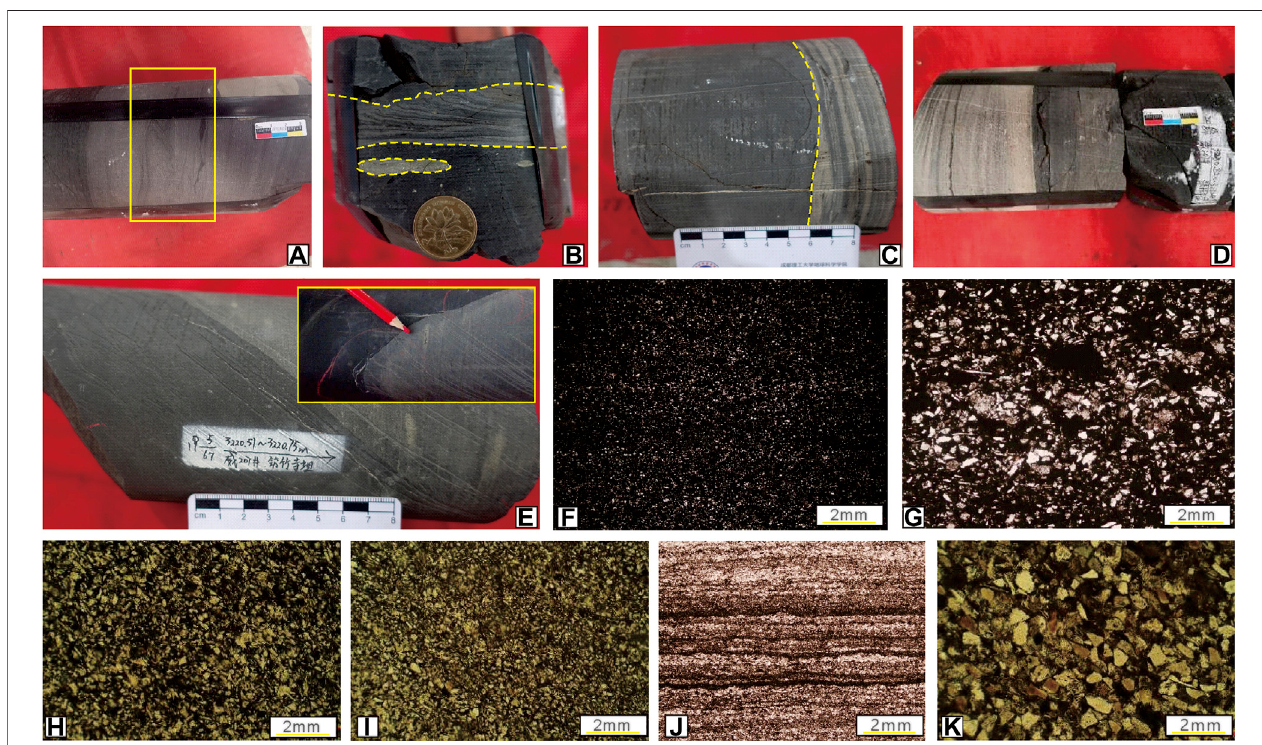
FIGURE3| Petrologicalcharacteristics ofQiongzhusiFm,W-207Well. (A) W207Well,3,232.80m,atthebottomofQiongzhusiFm,softsedimentdeformation (B) W207Well,3,231.66 m,atthebottomofQiongzhusiFm,crossbeddingandlenticularpyritenodules (C) W207Well,3,186.30 m,thelowerpartofQiongzhusiFm,black shale alternates with gray laminar calcareous shale (D) W207 Well, at the bottom of Qiongzhusi Fm, black shale is in contact with gray black siltstone, suspected of Bouma sequence (E) W207 Well, 3,220.57m, the lower part of Qiongzhusi Fm, black shale is in contact with gray elliptic calcareous nodules (F) W207 Well, 3,242.29 m,siltycalcareousmudstone (G) W207Well,3,242.29 m,siltycalcareousmudstone,withalargeamountofcarbonateclasts (H) W207Well,3,149.58 m,the middlepartofQiongzhusiFm,mainlycomposedofsiltymudstone andwithlittleargillaceoussiltstone (I) W207Well,3,088.35 m,theupperpartofQiongzhusiFm,felsic siltstone (J) W207 Well, 3,055.91 m, the upper part of Qiongzhusi Fm, normal grain sequence, suspected parallel bedding development, dolomitic lithic siltstone laminated siliceous shale and carbonaceous shale with the characteristics of turbidite deposition (K) W207 Well, 3,000.59 m, silty argillaceous very fi ne-grained quartz sandstone.